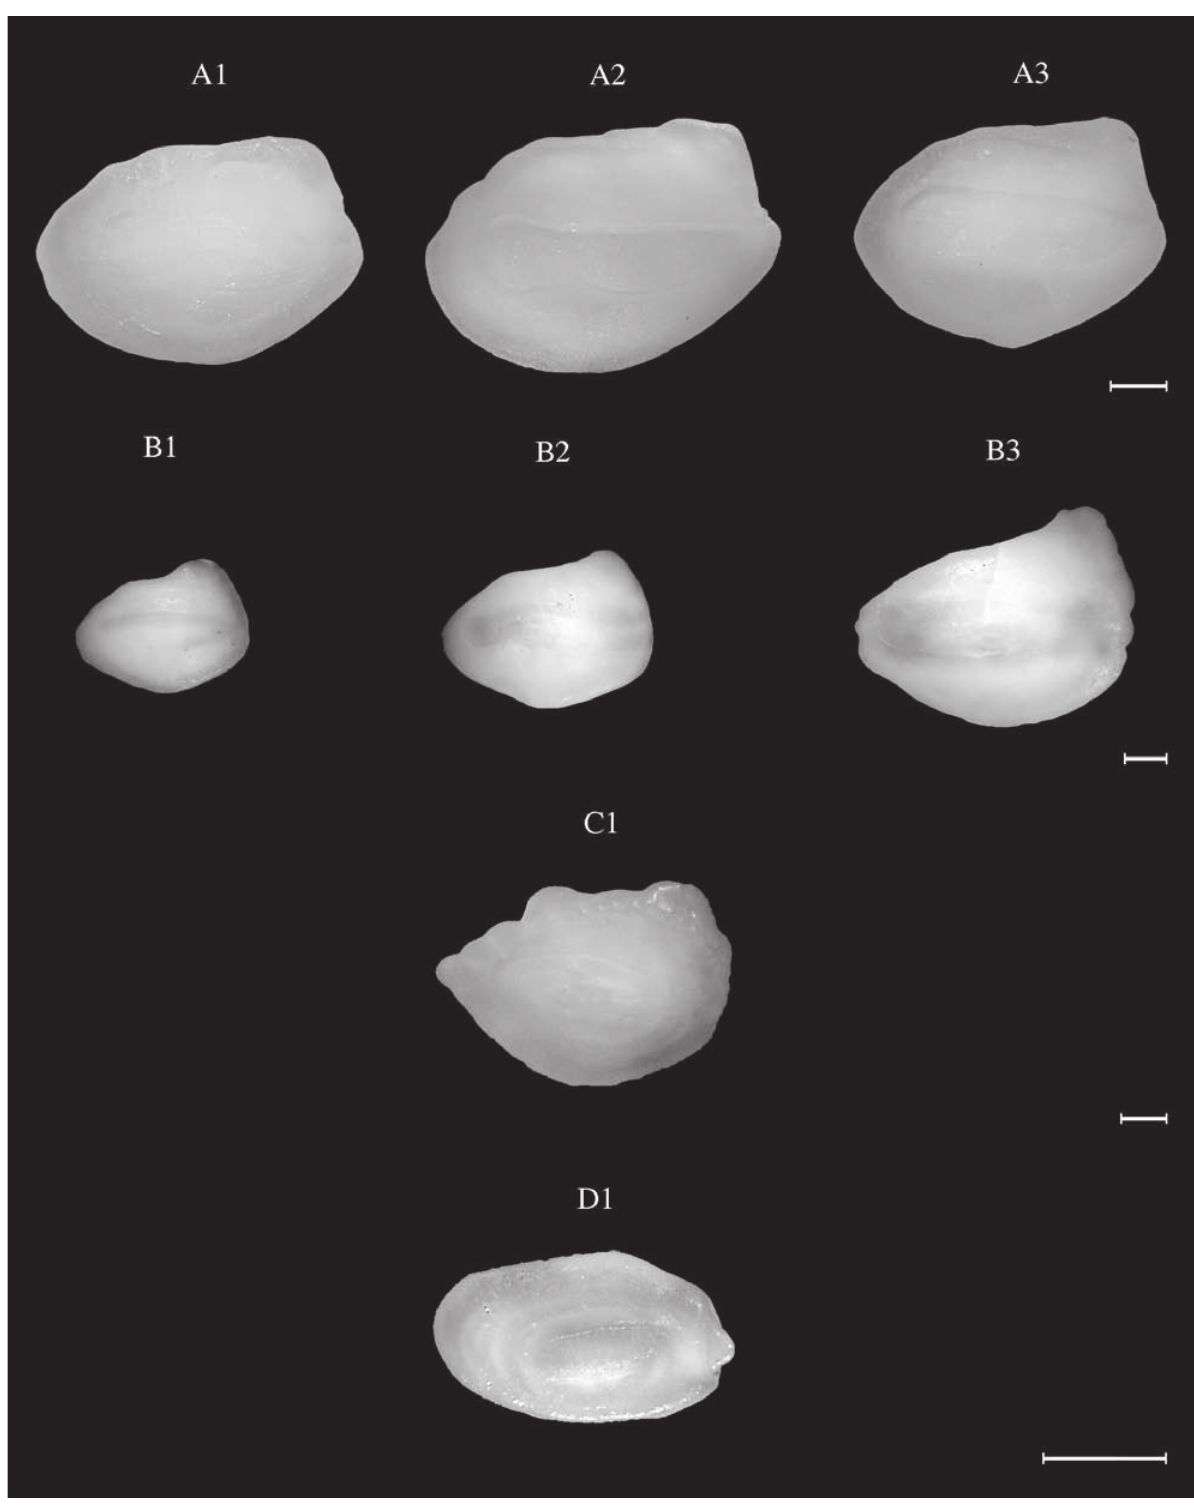
Fig. 33. – Benthocometes robustus. TL: A1, 11.2 cm (CEA); A2, 12.6 cm (NEA); A3, 14.7 cm (CEA). Ophidion barbatum (WM) . TL: B1, 10.0 cm; B2, 14.0 cm; B3, 19.0 cm. Ophidion rochei (WM) . TL: C1, 18.5 cm. Bellottia apoda (WM). TL: D1, 4.5 cm. Scale bar = 1